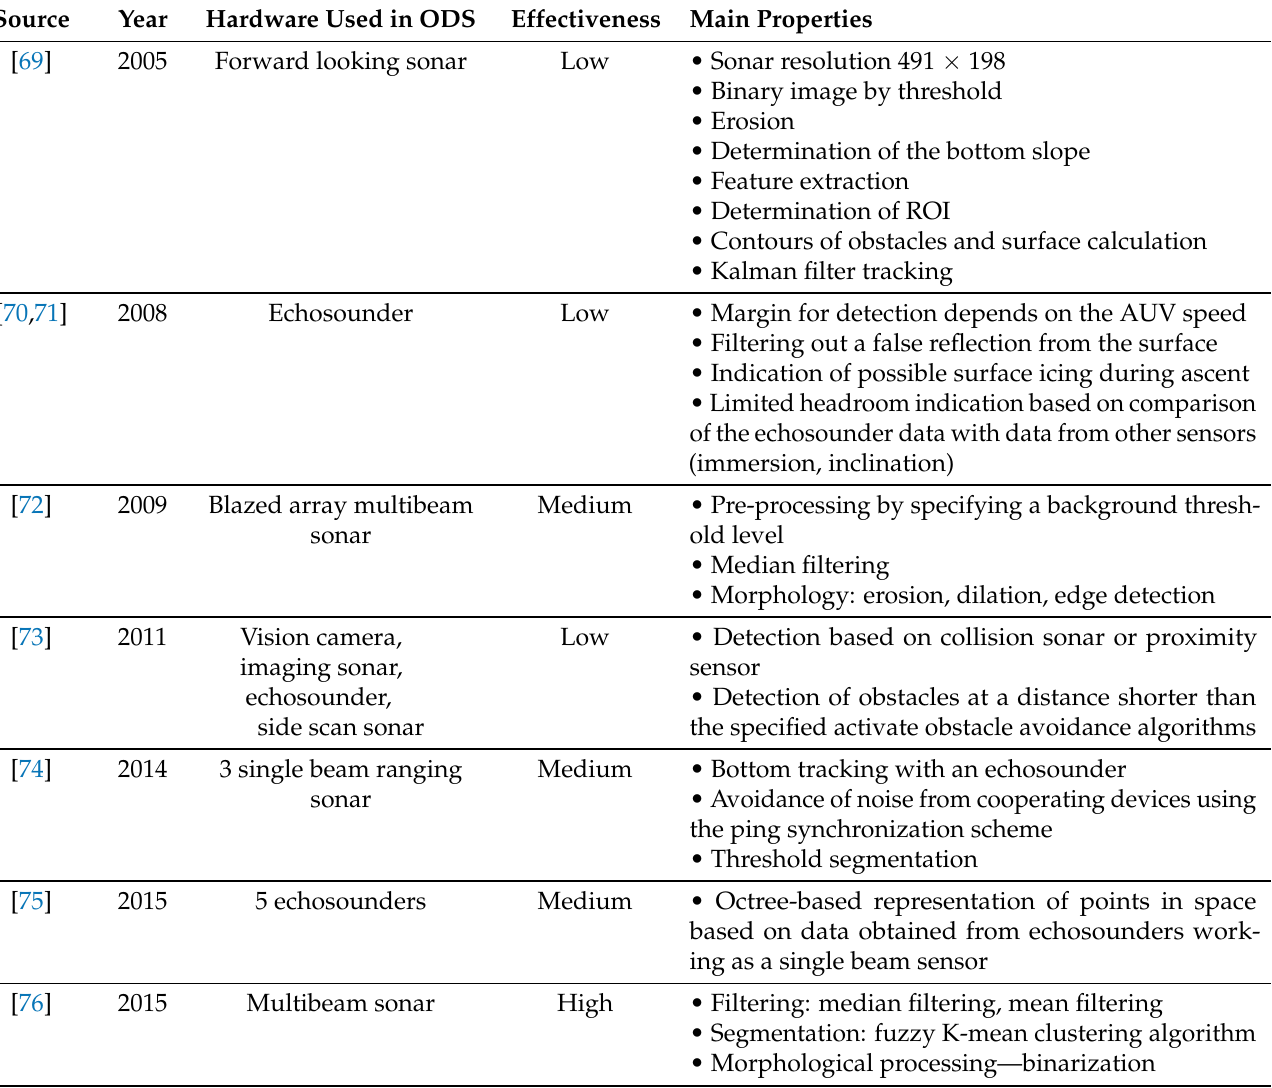
Table 2. Evaluation of AUVs Obstacle Detection Systems capable of collision